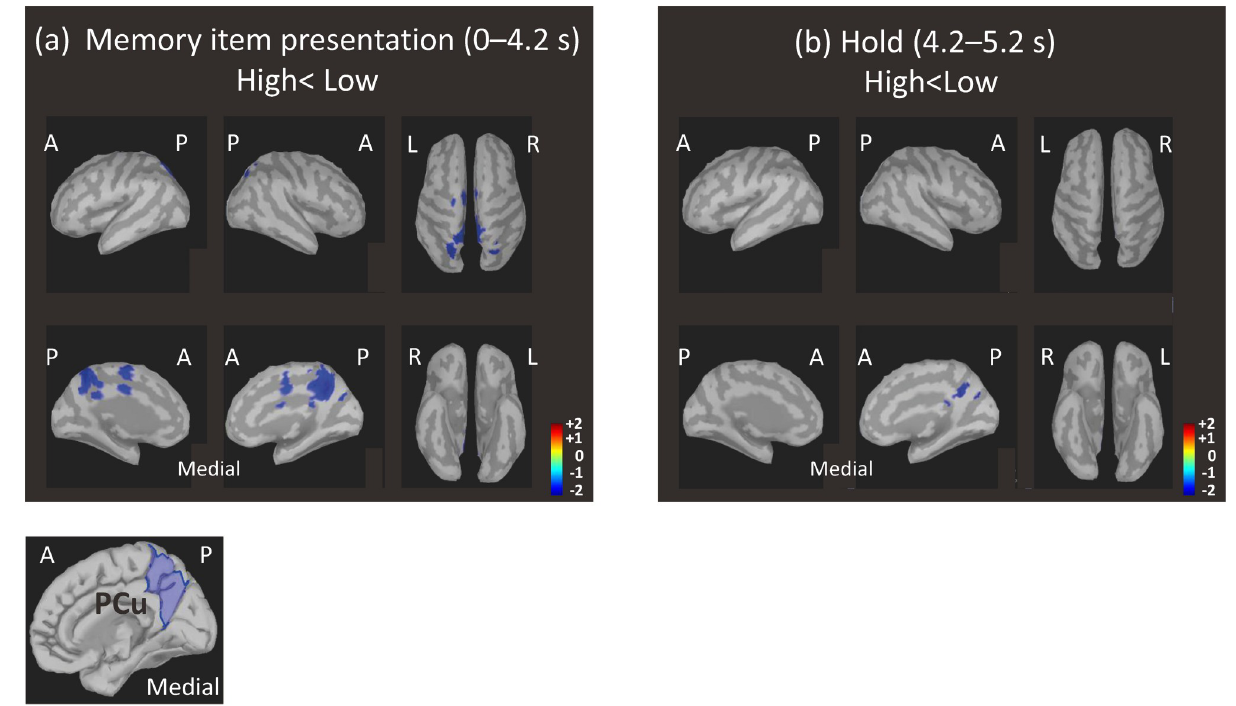
Fig 4. Brain regions in which standardized alpha-rhythm amplitude was significantly lower in the High group compared to the Low group. Amplitude modulations during the memory item presentation period ((a): 0–4.2 s) and to the hold period ((b): 4.2–5.2 s) were compared between groups by double-tailed t-test (p < 0.05). The predominant region coincided well with the precuneus (PCu) based on the Desikan-Killiany atlas (Left below). A: anterior, P: posterior, L: left, R: right.